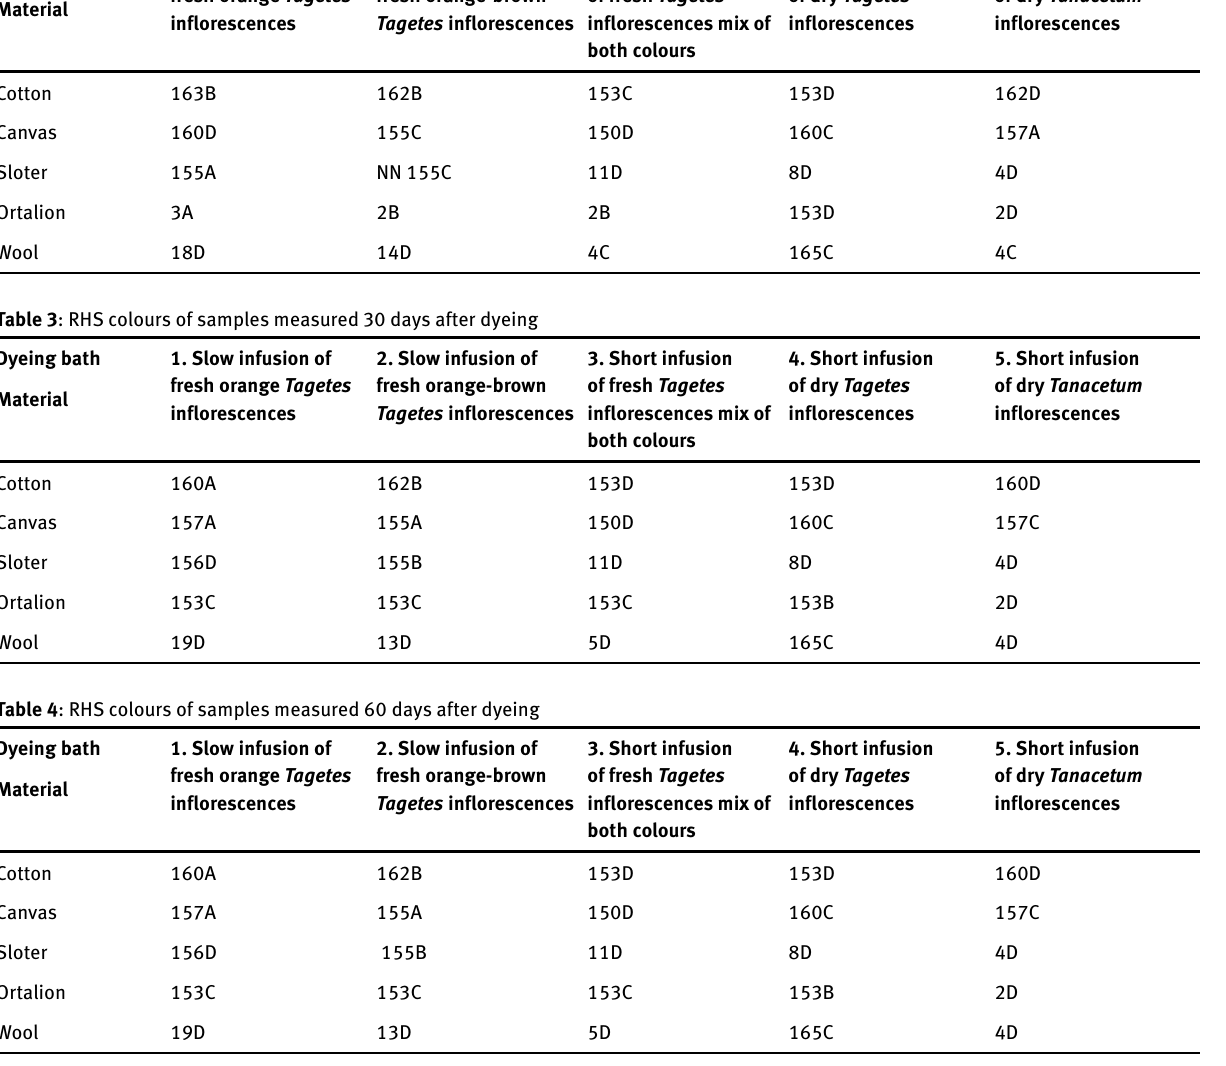
Table 2 : RHS colours of samples measured 24 hours after dyeing Dyeing bath